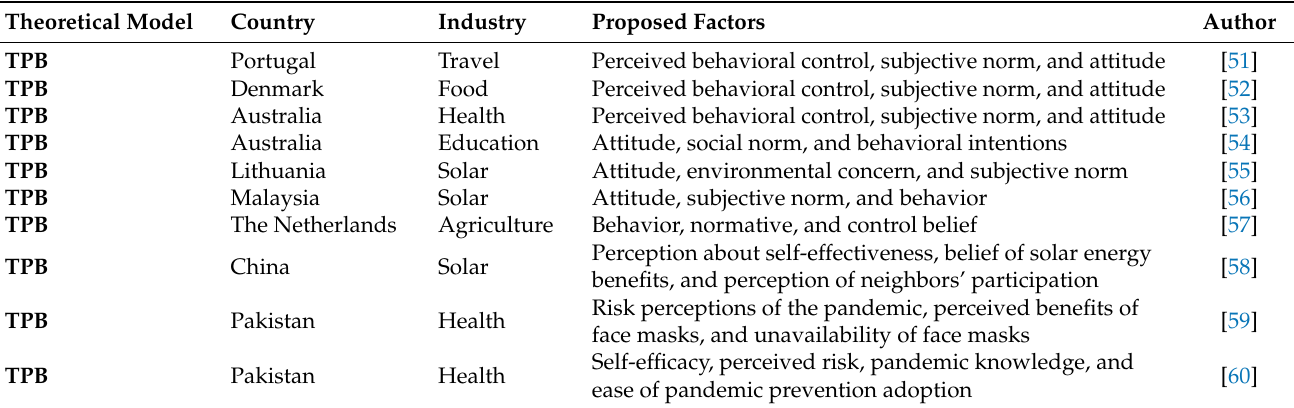
Table 1. Usage of TPB in different fields and